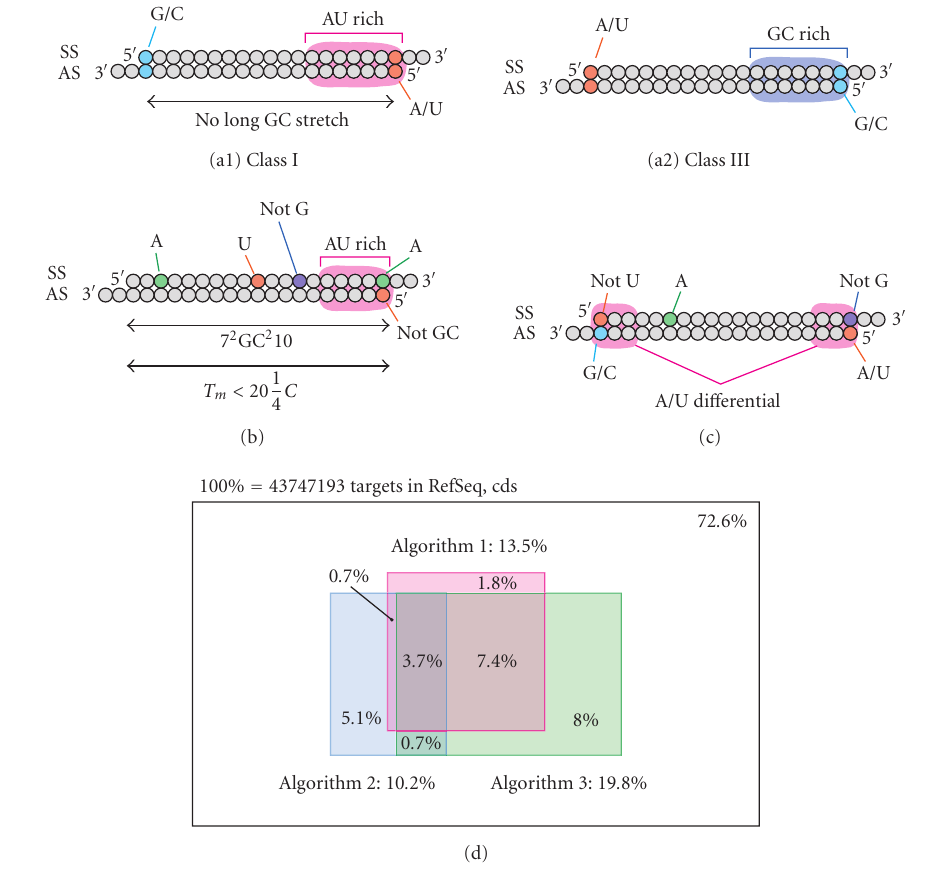
Figure 1: Three algorithms for siRNA design for functional RNAi in mammalian cells. (a) Algorithm 1. Highly functional class I siRNAs simultaneously satisfy the following four conditions: A/U at the 5 (cid:2) AS end, G/C at the 5 (cid:2) SS end, more than four A/U nucleotides in the 5 (cid:2) -terminal one-third of AS, and lacking a long G/C stretch in the 5 (cid:2) -terminal two-thirds of SS. Ine ff ective class III siRNAs possess features opposite to class I siRNAs. (b) Algorithm 2. There are 8 requirements for this algorithm: low G/C contents (30–52%), three or more A/U at the five 3 (cid:2) -terminal base pairs of SS, low internal stability lacking stable inverted repeats, and base preferences at SS positions 3, 10, 13, and 19. (c) Algorithm 3. A/U content in the 5 (cid:2) AS end should be higher than that in the 5 (cid:2) SS end. Base preferences are also required at positions indicated. (d) Di ff erence in functional siRNA prediction between three Algorithms, 1, 2, and 3. 43747193 siRNA sequences were collected from human RefSeq sequences and classified using three